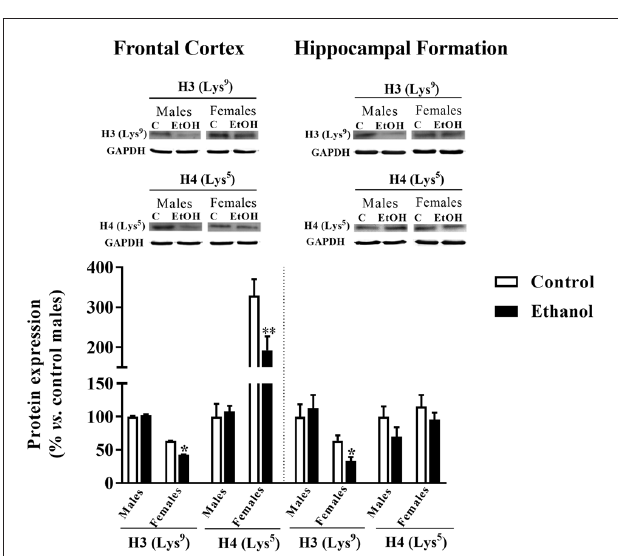
FIGURE 8 | Epigenetics markers. Protein expression levels of H3 (Lys 9 ) and H4 (Lys 5 ) in the FC (left panels) and the HF (right panels) of adult male and female rats that were exposed to a ethanol (20% in drinking water) or tap water for 2-h sessions during 3 days, and for an additional 4-h session on the 4th day, every week during adolescence, from pnd 28–52. Histograms (mean ± SEM) represent the protein levels expressed as values of optical density calculated as changes from the control male group (%). t Student, ∗ p < 0.05, ∗∗ p < 0.01 compared with the corresponding control group. n = 5–8 per experimental group, coming from four